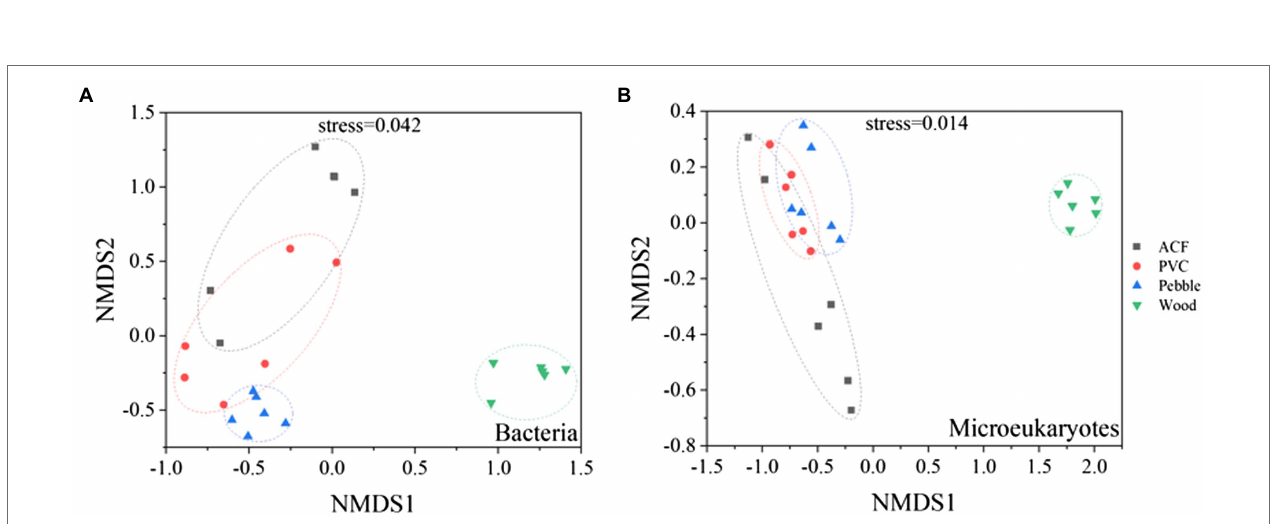
FIGURE 2 | Non-metric multidimensional scaling (NMDS) plots depict bacterial (A) and microeukaryotic (B) biofilms on artificial (ACF and PVC) and natural (pebble and wood) substrates using the phylogenetically weighted UniFrac distance matrix. Statistical comparison between different samples was deduced by permutational multivariate ANOVA (PERMANOVA), and results are provided in Supplementary Table S6